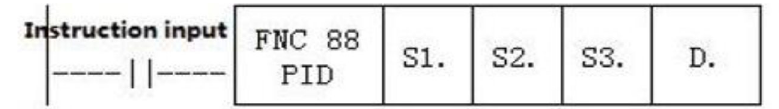
Figure 11. PID control block in the PLC.